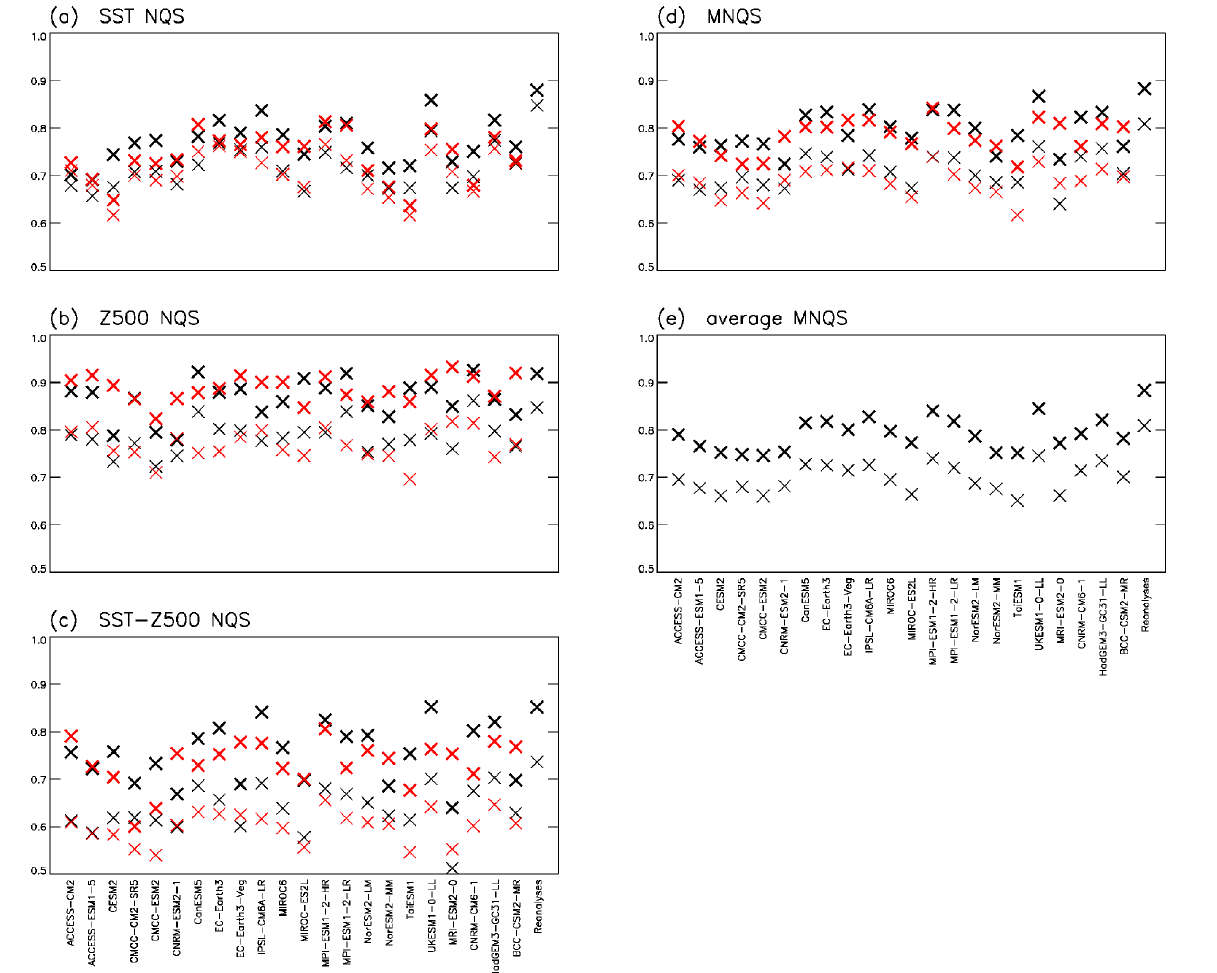
Figure 4. Network quality scores (bold) and pointwise network quality scores (thin) of CMIP6 models with respect to CERA-20C (black) and 20CRv3 (red) over the time period 1951–2010. (a) Networks for SST fields, (b) networks for Z500 fields, (c) cross-networks between SST and Z500 fields. (d) Multivariate network quality scores, (e) average of the two multivariate network quality scores for CERA-20C and for